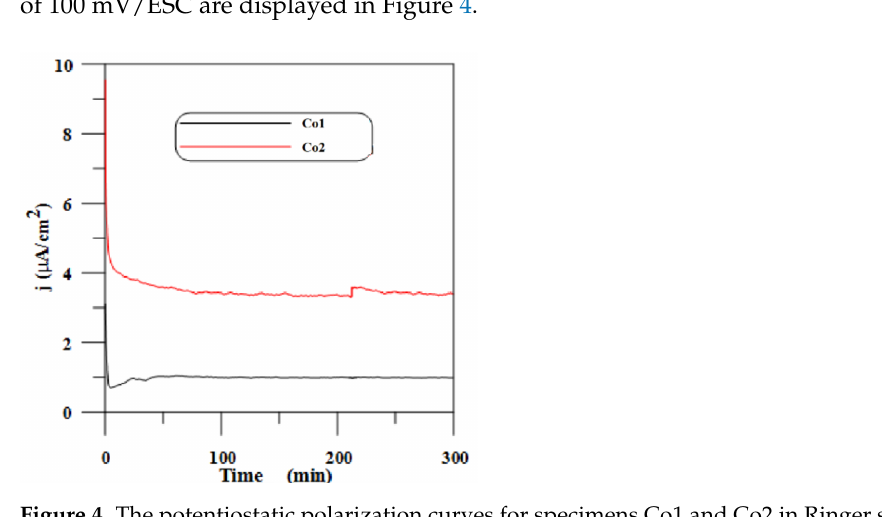
Figure 4. The potentiostatic polarization curves for specimens Co1 and Co2 in Ringer solution at a potential of 100